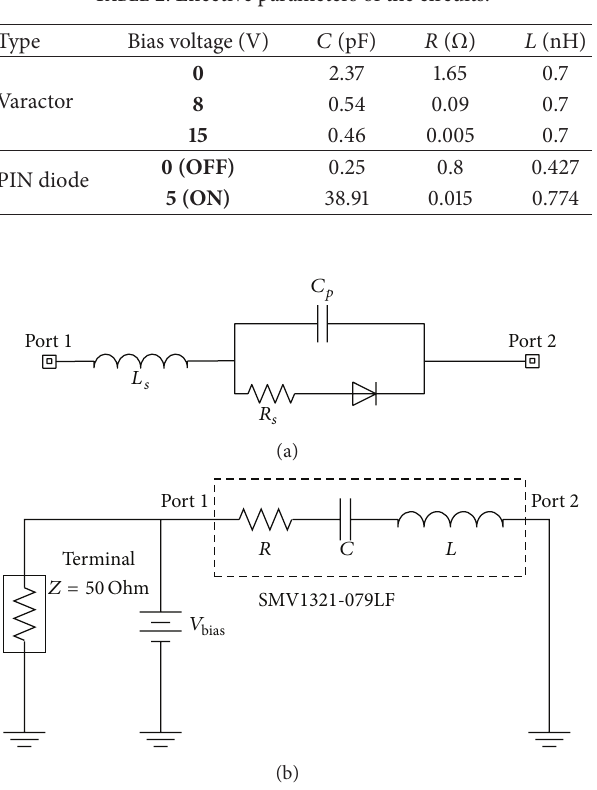
Table 2. To put it in another way, in this design, ON state